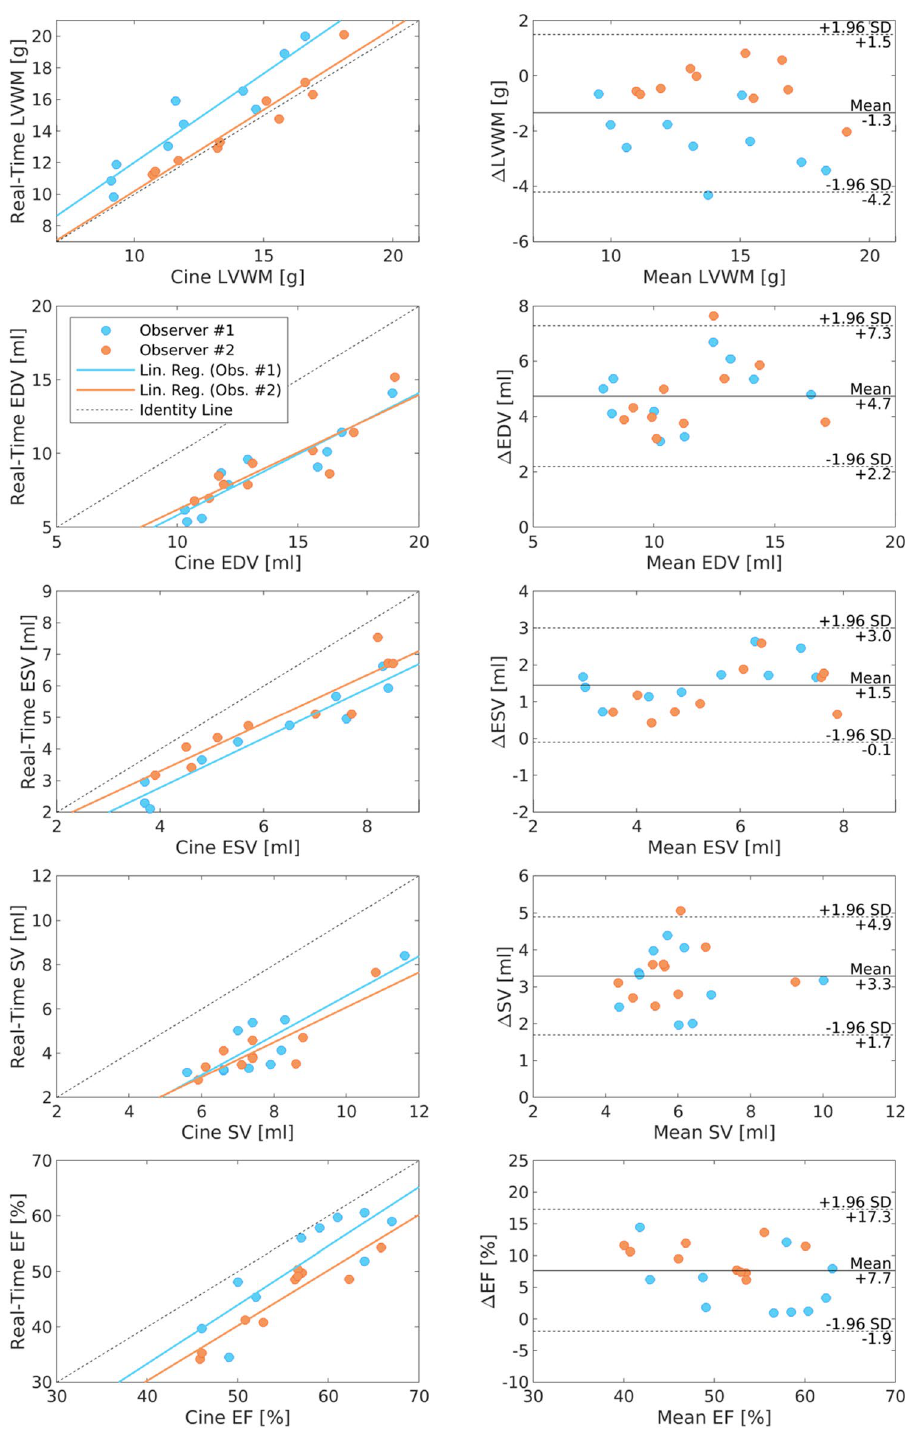
Figure 2. Comparison of cine MRI and RT-MRI. Correlation and Bland–Altman plots of LVWM, EDV, ESV, SV and EF comparing cine MRI and RT-MRI of the first study time point (test). RT-MRI significantly underestimates volumetric parameter by 20% to 40% when taking cine MRI as gold standard. However, regression analysis comparing estimated parameter by RT-MRI and cine MRI revealed a strong correlation. LVWM: Left Ventricular Wall Mass; EDV: End-Diastolic Volume; ESV: End-Systolic Volume; SV: Stroke Volume; EF: Ejection